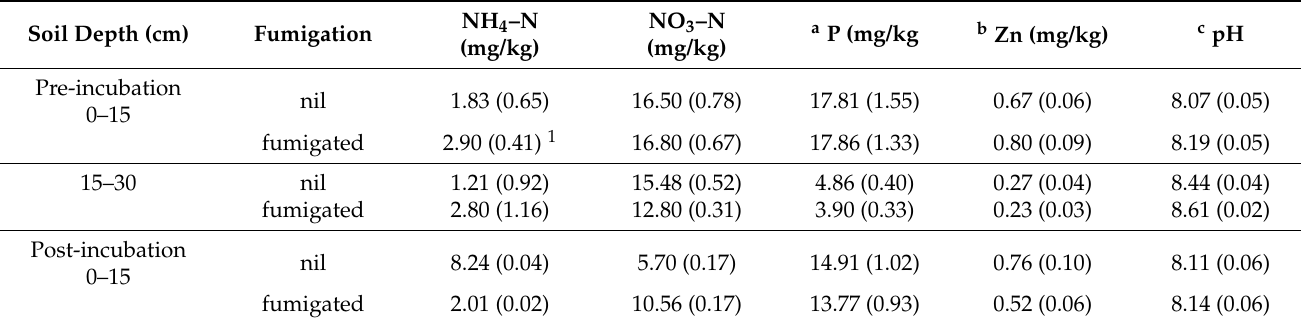
Table 5. Effect of fumigation on soil chemical properties in Experiment 3, before and after incubation for 28 days. Values are the means of n = 15, with SE in parentheses, n =